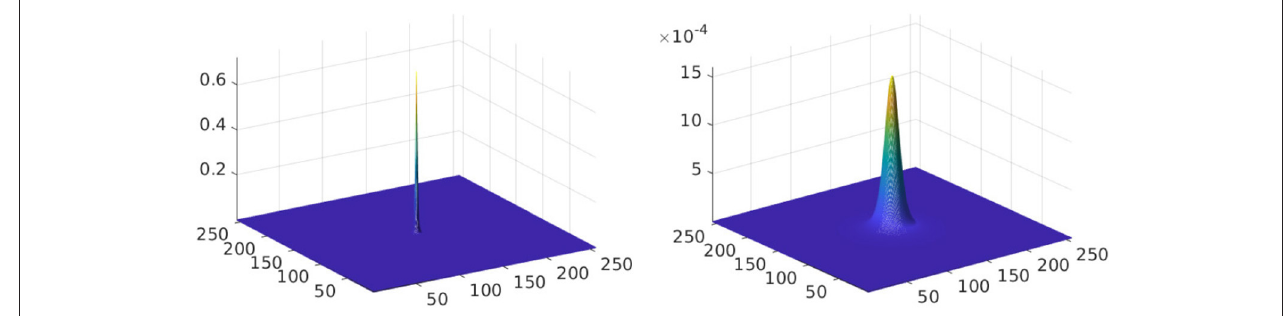
FIGURE 8 | RHOSVD approximation of the discretized cubic potential 1